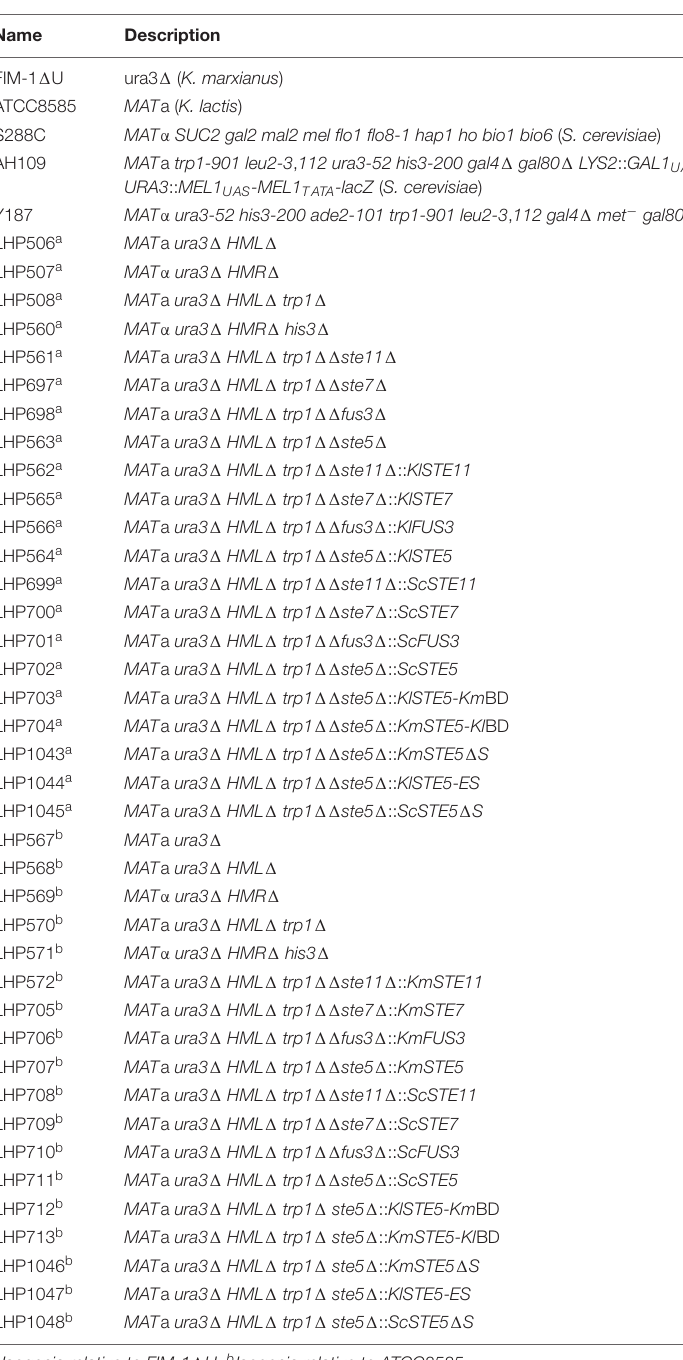
a Isogenic relative to FIM-1 (cid:49) U. b Isogenic relative to ATCC8585.